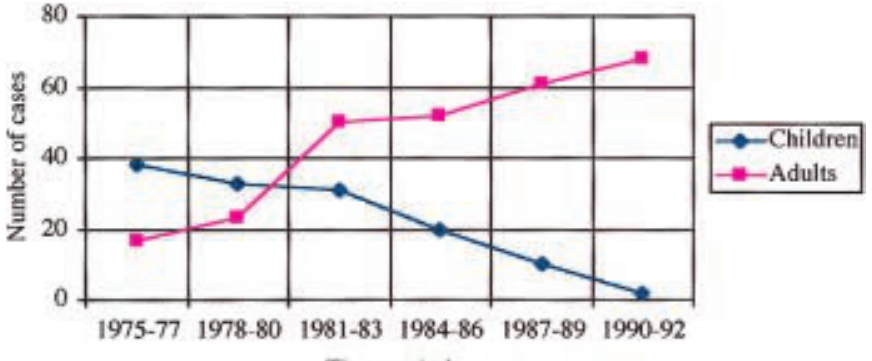
Incidence of acute epiglottitis in Rhode Island 1975–1992 [ 3 ]